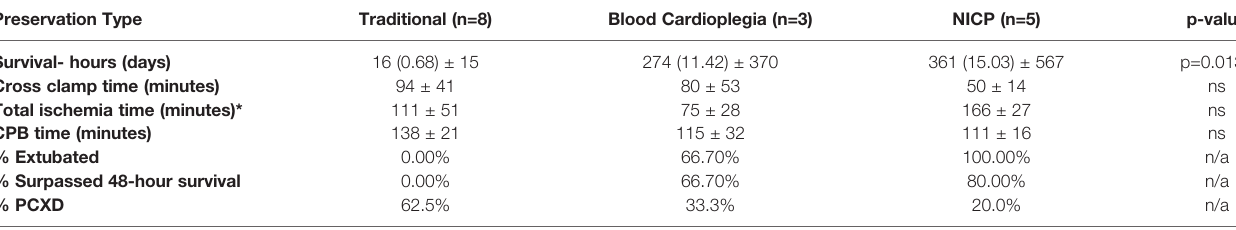
TABLE 3 | Mean survival, descriptive statistics between traditional, blood cardioplegia and NICP.